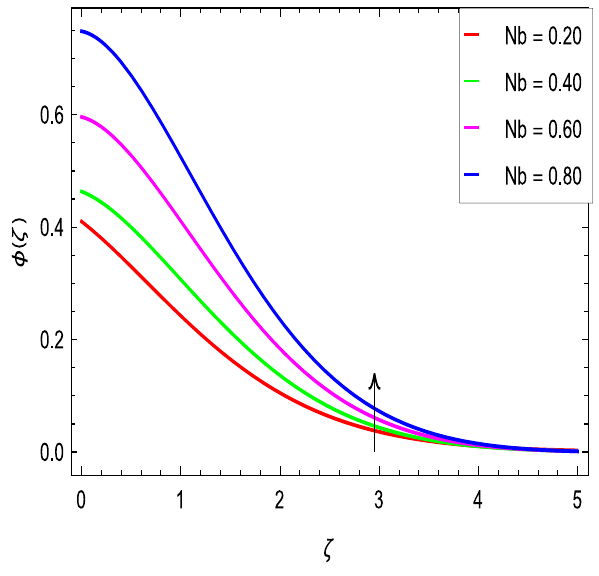
Figure 18. φ(ζ) in terms of Nb .